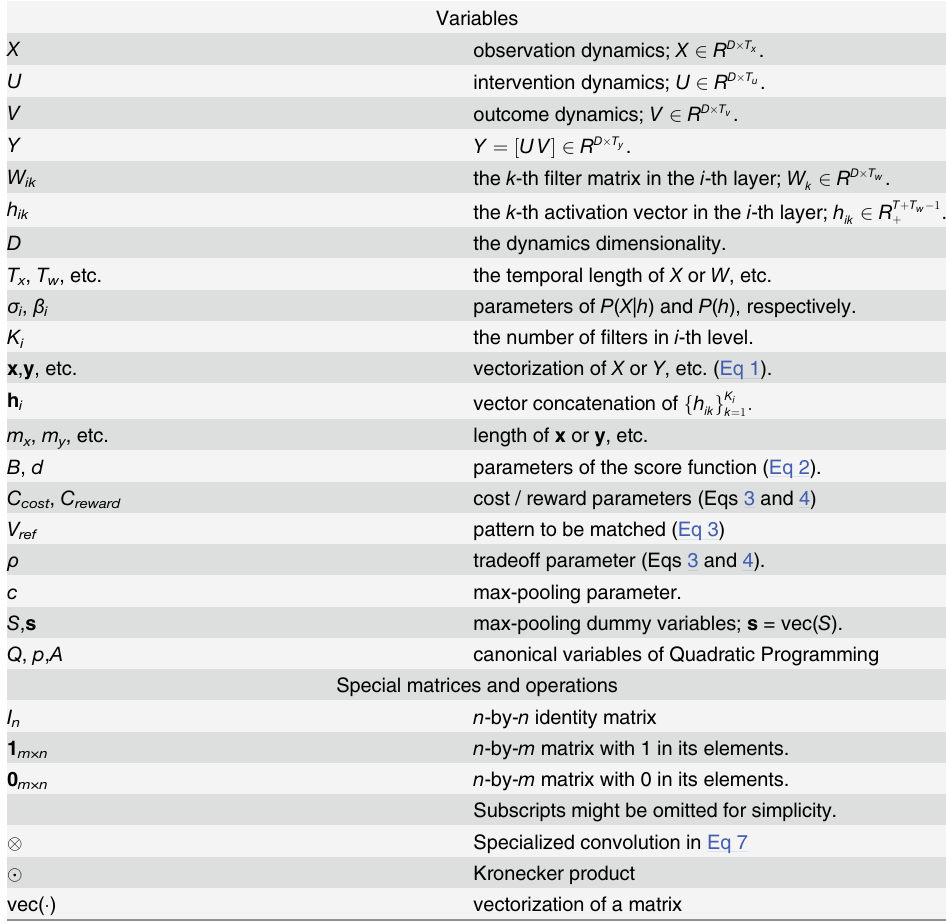
Table 1. Summary of notations used in this paper.